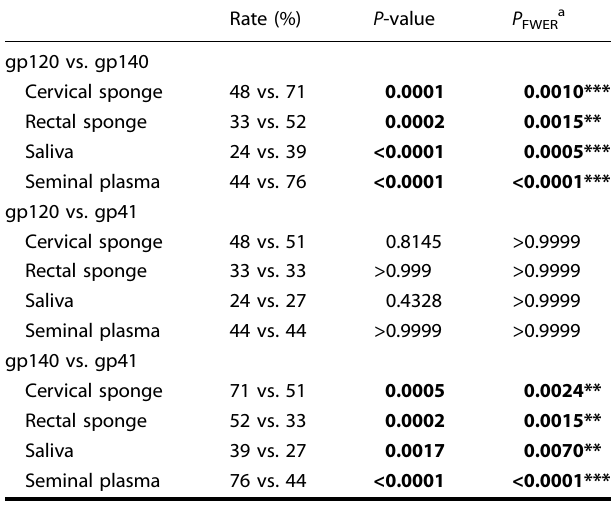
mucosal compartments.